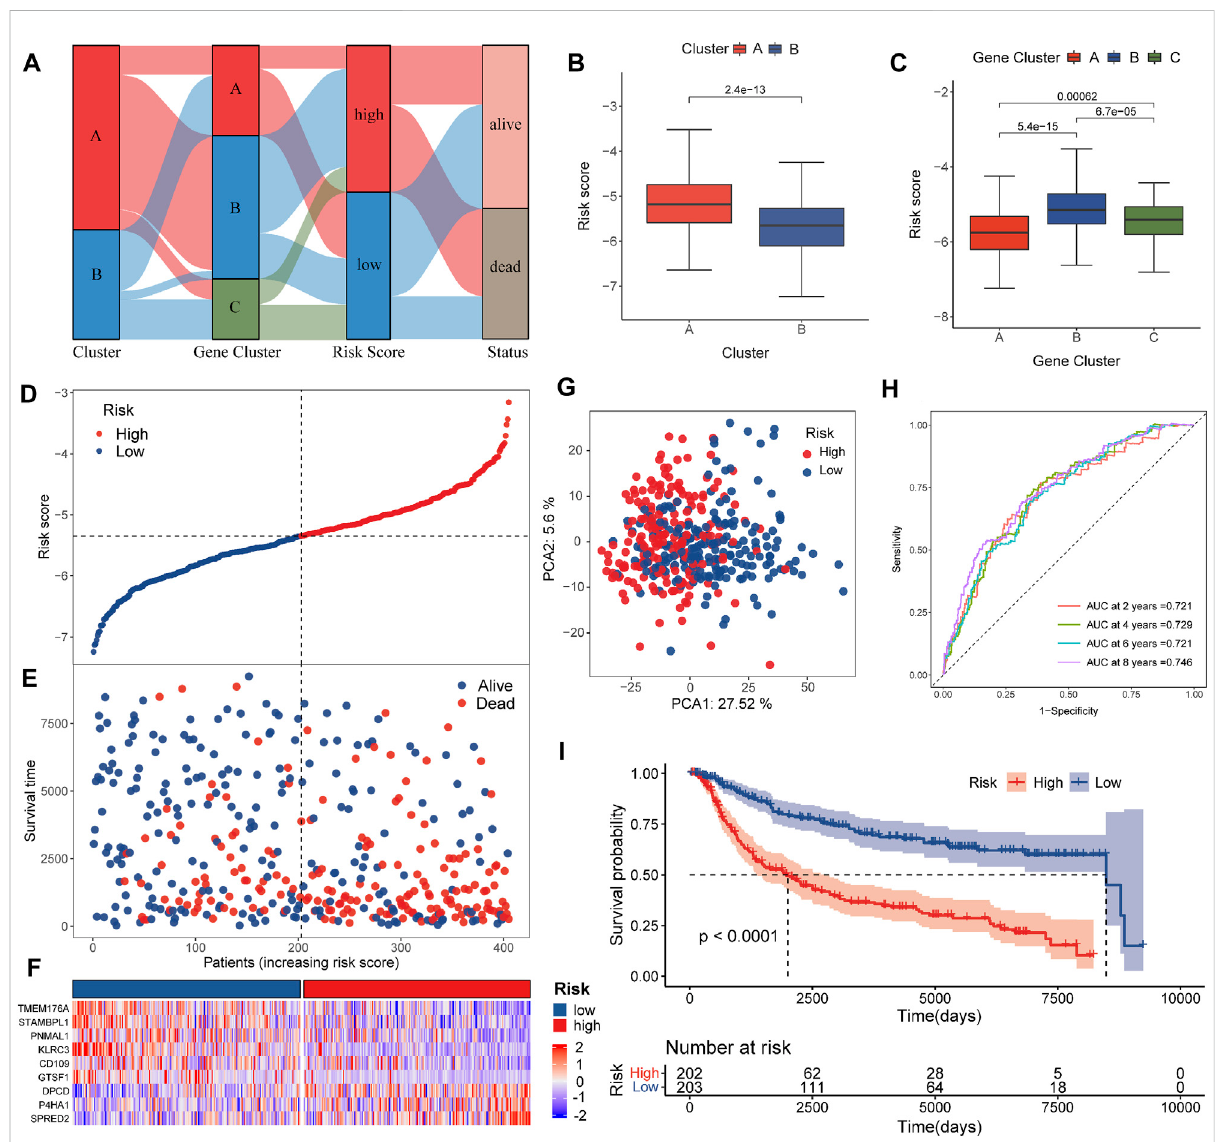
FIGURE 4 Construction of the risk score in the training set. (A) Alluvial diagram of cluster distributions in groups with different risk scores and survival statuses. (B) Differences in risk score between the pyro-clusters. (C) Differences in risk score between the pyro-gene clusters. (D,E) Ranked dot and scatterplotsshowingtheriskscoredistributionandpatientsurvivalstatus. (F) Differencesintheexpressionofninegenesoftheprognosticsignature between the two pyro-clusters. (G) PCA analysis shows a remarkable difference in transcriptomes between the risk groups. (H) ROC curves to predictthesensitivityandspeci fi cityof2-,4-,6-,and8-yearsurvivalaccordingtotheriskscore. (I) Kaplan – MeieranalysisoftheOSbetweentherisk